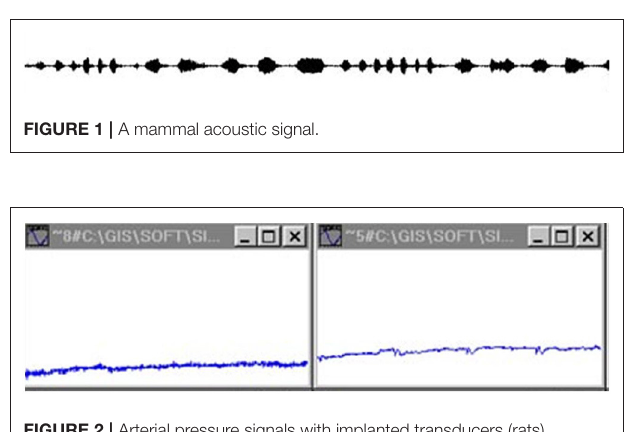
FIGURE 2 | Arterial pressure signals with implanted transducers (rats) (Jovanovi´c, 2001; Jovanovi´c et al.,